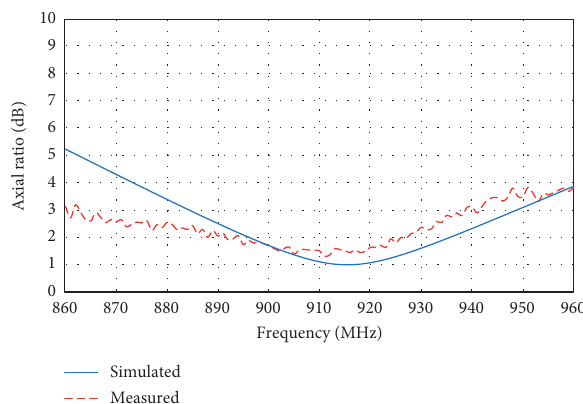
| of the UHF-RFID tag 11